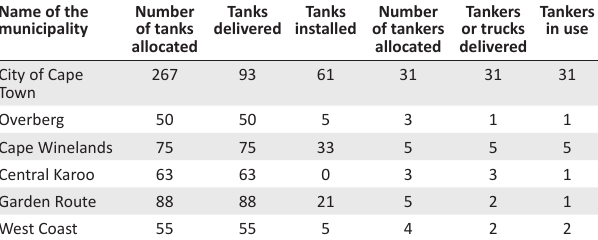
Number of tanks allocated